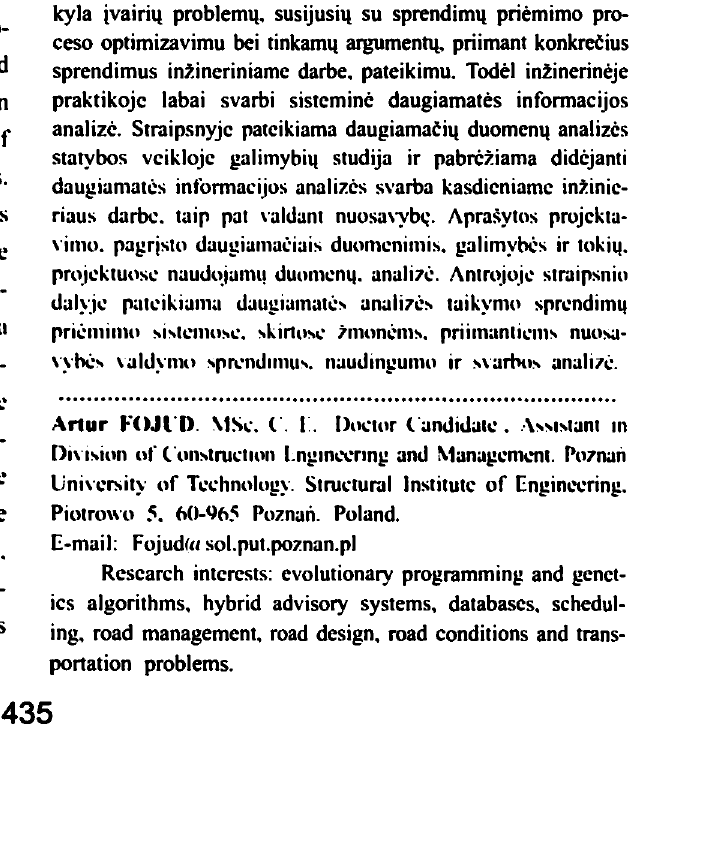
The .,8" perspective presents the result of the analysis which provided an answer to the question as to which elements still remain in the state assumed for them in a chosen time span pointing, for example, at the elements which have not become degraded since the previous